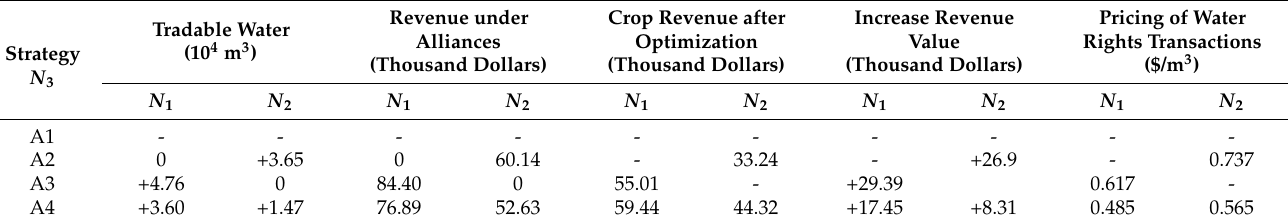
Table 8. Water rights trading price under N 3 Strategy.